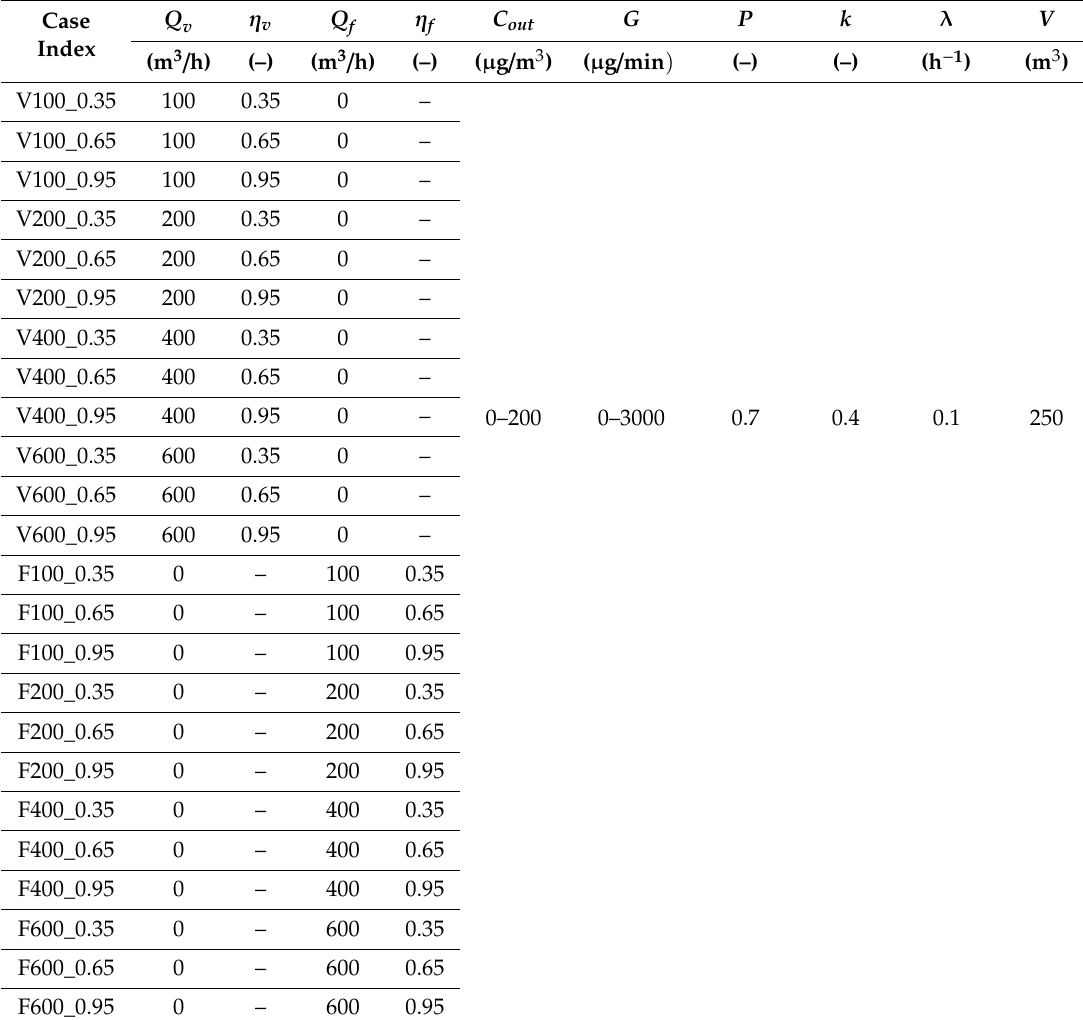
Table 7. Simulation case for assessing combined effect of parameters on indoor PM2.5.